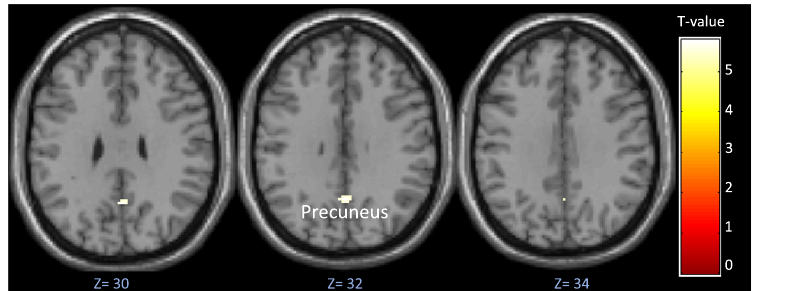
Fig. 3 Map of precuneus activation negatively predicted by subjective threat appraisal ratings in participants with psychotic experiences. The need-for-care and non-need-for-care participants are combined. Cluster-forming threshold FWE-corrected p = 0.015; whole brain voxel threshold p < 0.05